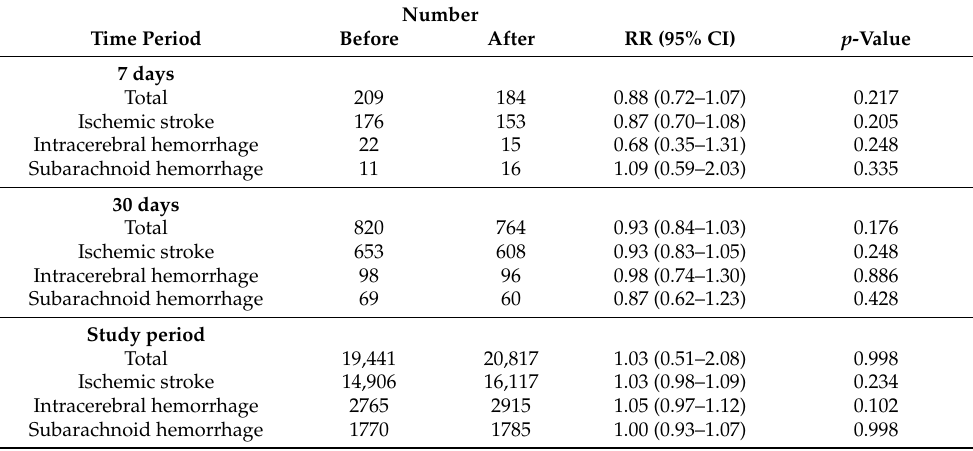
Table 1. Occurrence of stroke before and after restaurant smoking ban within 7 days, 30 days, and whole study period (761 days before and after the ban). Rate ratio (RR) comparing after vs. before the